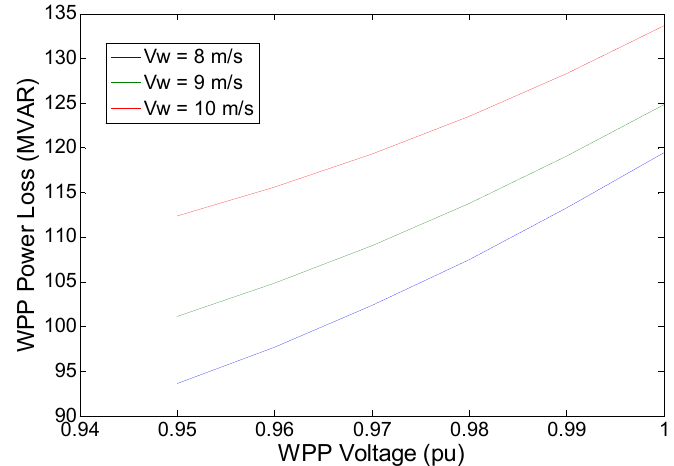
Figure 10. Variation of WPP active power loss.